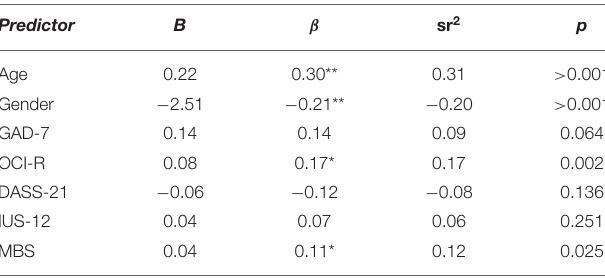
TABLE 7 | Linear Regression Predicting Prepping Behaviors as measured by the SBQ ( n = 373).